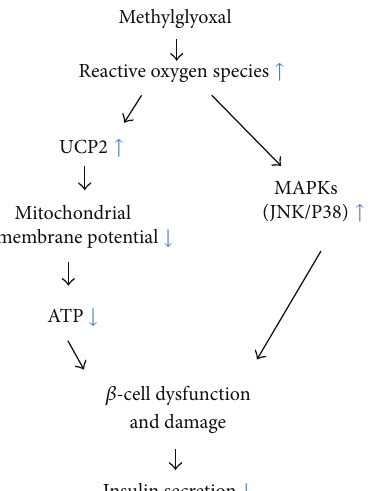
Figure 9: Schematic representation of proposed signaling pathways suggested by the results of this study. Methylglyoxal increases productionofreactiveoxygenspecies(ROS),whichthenreducesthe mitochondrial membrane potential (MMP) and ATP production via UCP2 upregulation. UCP2 upregulation in turn leads to 𝛽 -cell damage and, ultimately, impairment of insulin secretion. ROS also may induce 𝛽 -cell damage and impair insulin secretion directly via upregulation of MAPKs